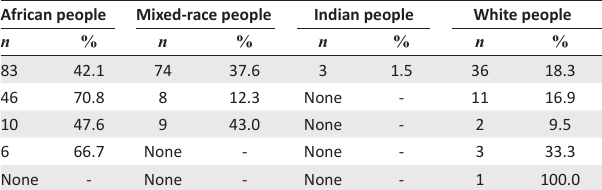
TABLE 2: Breakdown of postgraduate qualifications per race ( n =